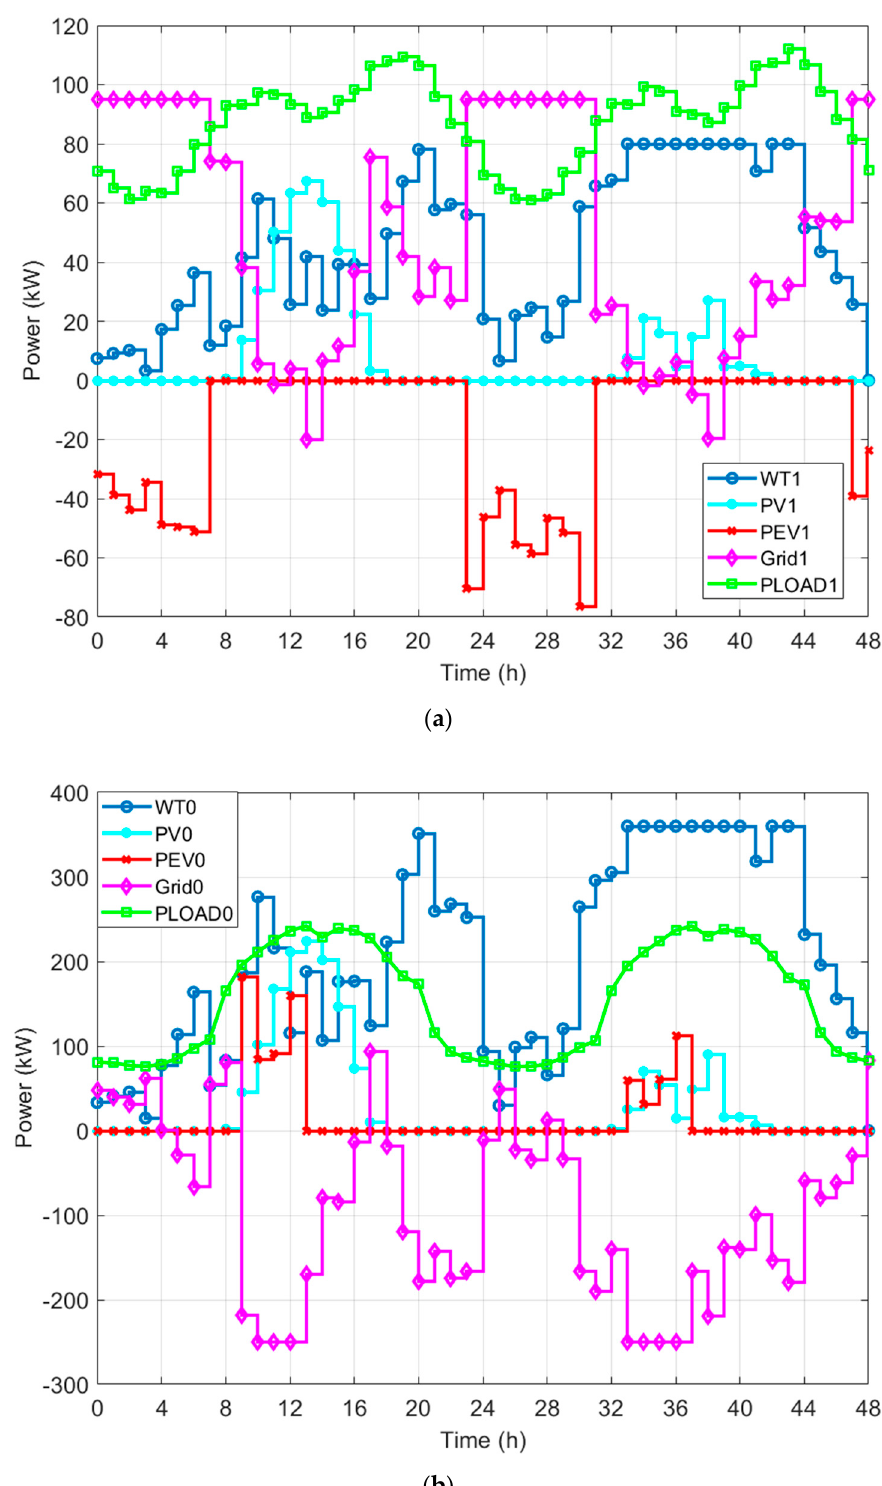
Figure 9. Dispatching results in Case 4: ( a ) Dispatching profiles of RMG1; ( b ) Dispatching profiles of OBMG.